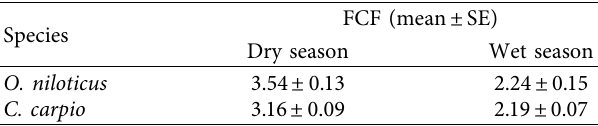
Table 4: Summary of the Fulton Condition Factor for the two fish species recorded in Lake